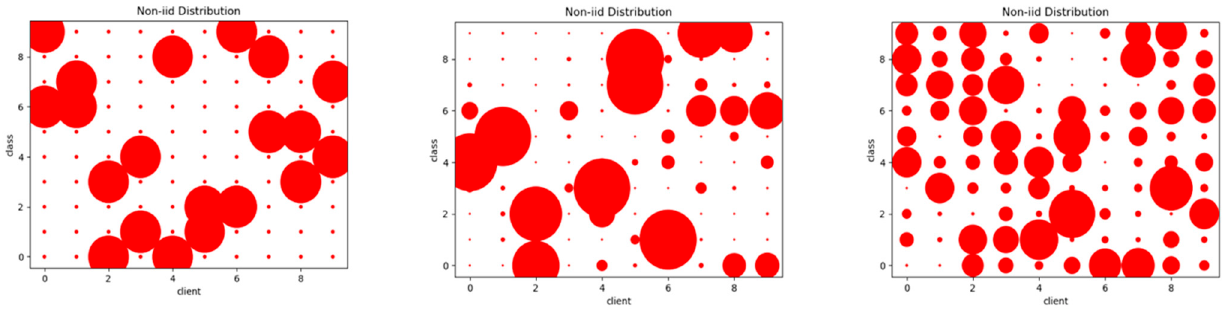
Figure 14. The distributions under different non-IID data settings. Table 2. The performances of FedAvg, FedDF, and FedUA under different non-IID data. Settings illustrated in Figure 14. (Fed- α -Step and FedUA-FedAvg denote the Percentages of Accuracy Change vs. Parameter α when we take the Step method’s and FedAvg’s results as the reference, respectively.) Classification Accuracy vs. Parameter